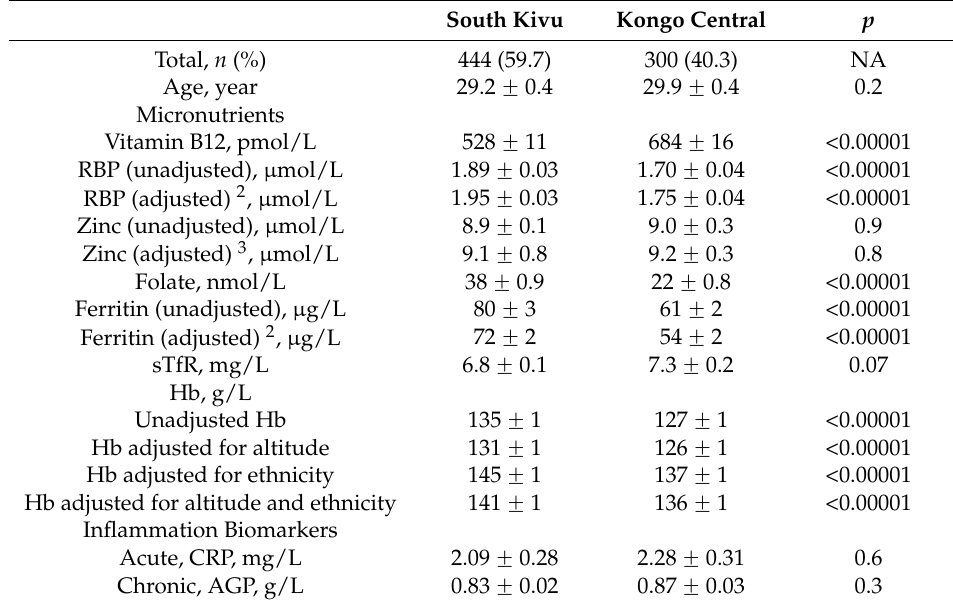
Table 2. Mean ˘ SEM age and concentration of micronutrients, hemoglobin, and